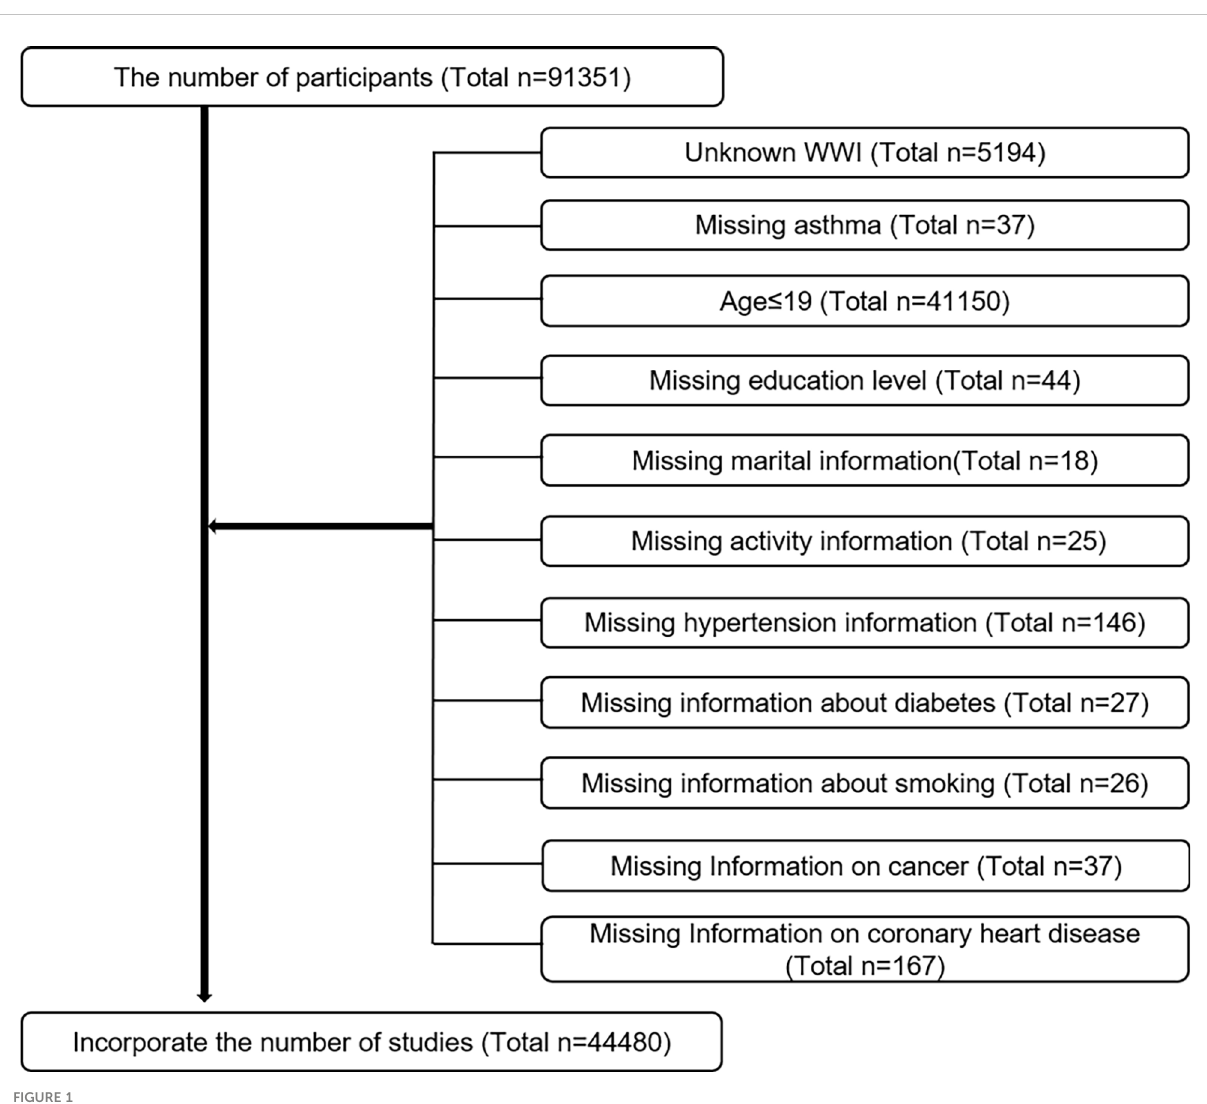
FIGURE 1 The participants selecting fl ow